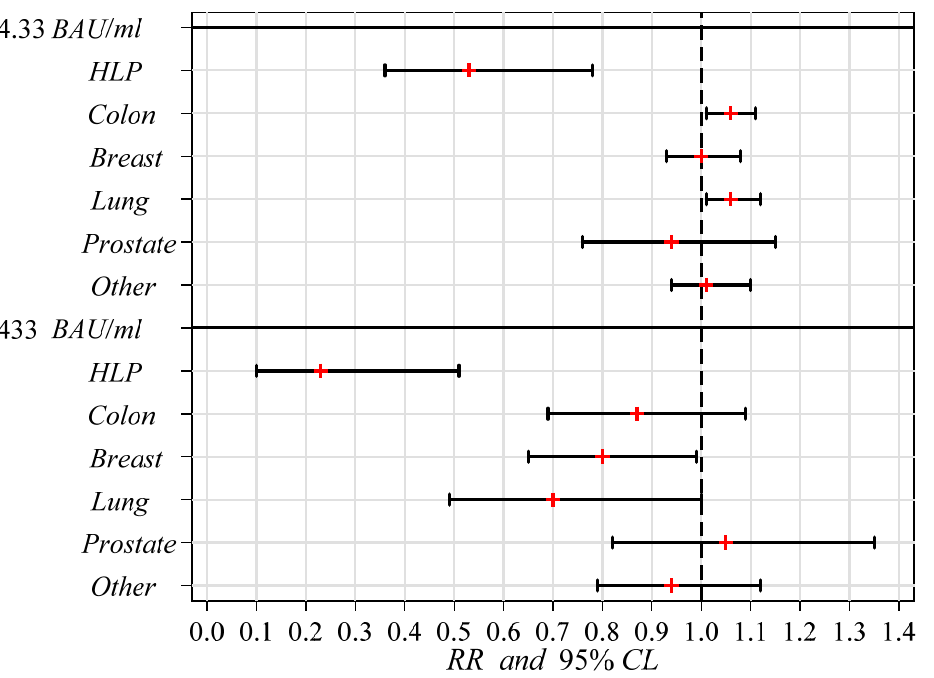
Figure 1. Caterpillar-plot of variations in positive ( IgG > 4.33 BAU/mL ) or highly positive ( IgG > 433 BAU/mL ) serologic responses of each cancer group with respect the healthy controls. Legend: RR , (red plus sign) ratio between the seropositivity rates of each cancer group and control group, estimated through the Poisson regression analysis; 95% CL , (whiskers) 95% confidence limits for RR; RR = 1, (vertical dashed line) rates in both groups are equal; RR < 1, rate in cancer group is less than that in control group; RR > 1, rate in cancer group is greater than that in control group. When the whiskers do not cross the vertical dashed line, the difference between the two rates is statistically